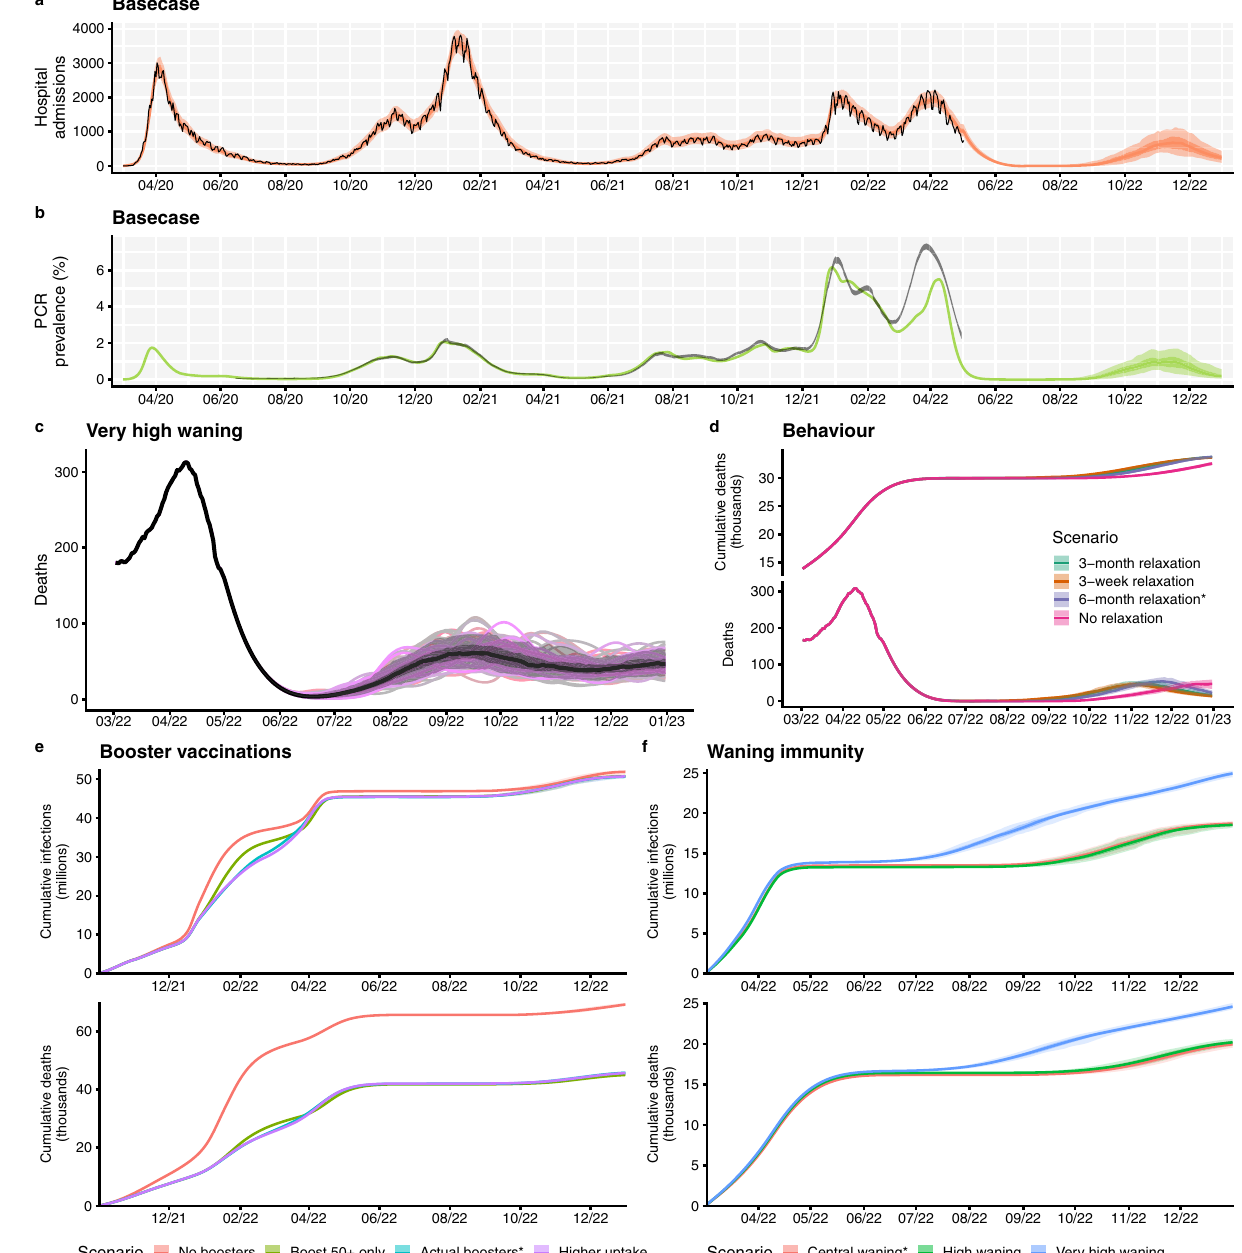
Fig. 4 | Summary of basecase model fi ts and projections and key results on uncertainty, behaviour, booster vaccinations and waning immunity. a The number of COVID-19 hospital admissions in England, for the basecase scenario, between March 2020 and December 2022. Black lines show reported data, pro- vided by UKHSA. Coloured lines and shaded areas show medians, 50% and 90% interquantile ranges from the fi tted model and from the model projection. b PCR prevalence in England, for the basecase scenario, between March 2020 and December 2022. The black ribbons show 95% con fi dence intervals for PCR pre- valence data. Coloured lines and shaded areas show medians, 50% and 90% inter- quantile ranges from the fi tted model and from the model projection. c The fi tted and projected number of COVID-19 deaths in England between March and December2022,shownfortheveryhighwaningscenario(seeTableS4).Theblack lineshowsthemediantrajectoryofCOVID-19deathsinEnglandovertime,withthe shaded areas showing the 50% and 90% interquantile ranges. Individual model